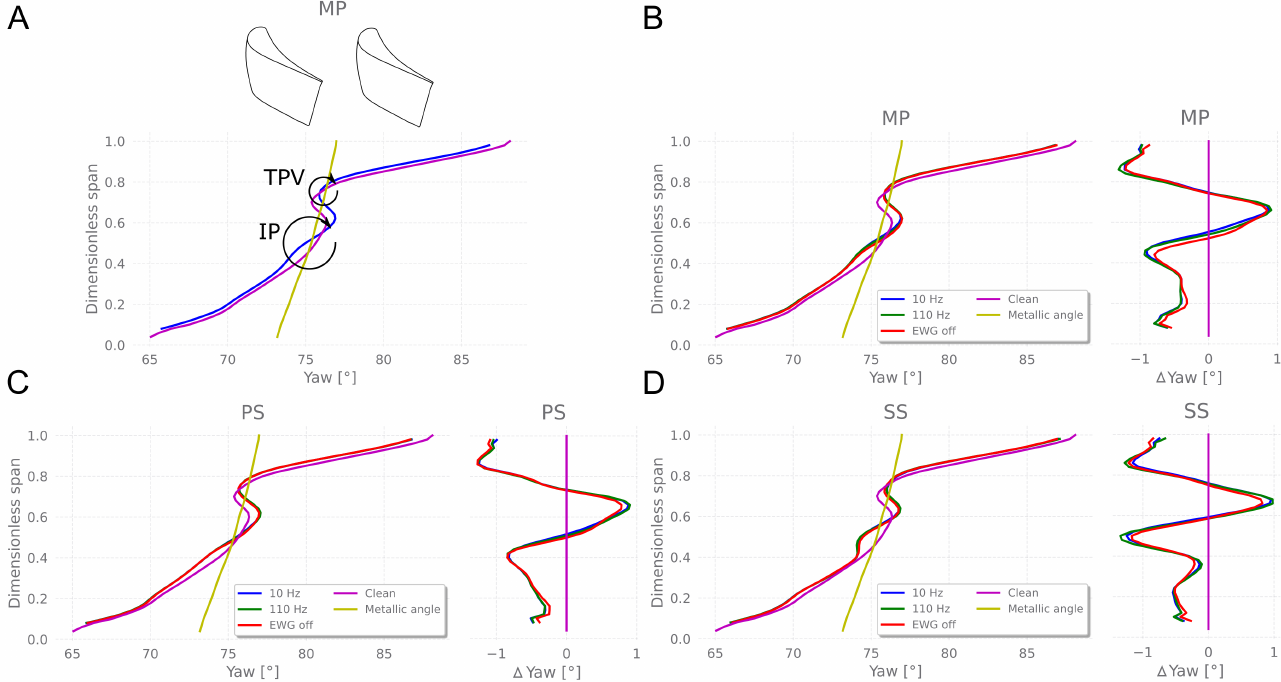
Figure 6. Circumferential mass average flow angle downstream of the stator (plane T2) at different passage aligned injecting positions (MP, PS and SS). Measurements are carried out with EWG switched off (“EWG off”), injecting EW at 10 and 110 Hz (“10 Hz” and “110 Hz” respectively) and without the EWG exploiting uniform inlet condition (“Clean”). Metallic angle line represents the geometric stator exiting angle. Frame ( A ): “Clean” and “10 Hz” cases comparison for MP. Frames ( B – D ): flow angle and its difference with respect to the “Clean” case for MP, PS and SS cases, respectively. Blade mirrored in frame A to ease the reading compared to flow